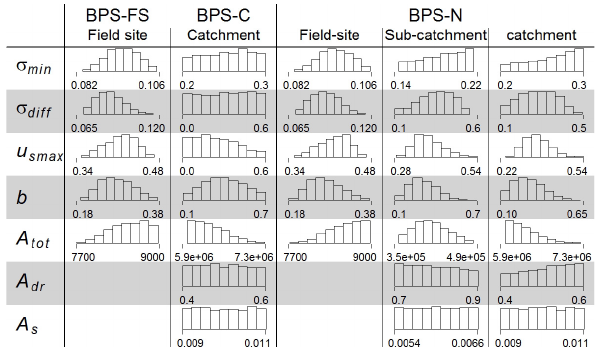
Fig. 10. Scale-specific parameter distributions for the three behav- ioral parameter sets: BPS-FS, BPS-C, and BPS-N.